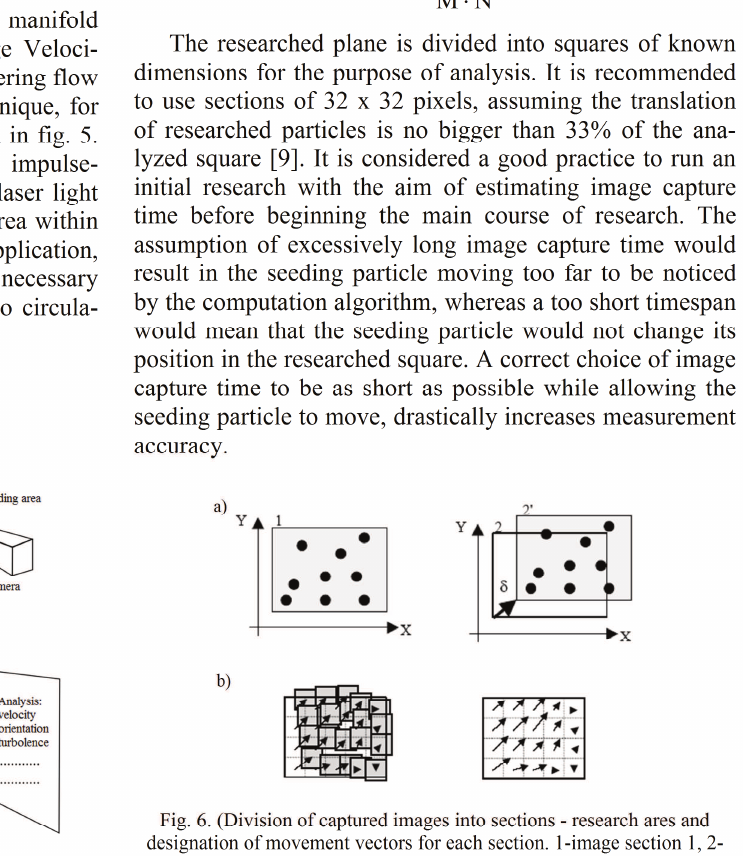
Fig. 5. Measurement scheme of DPIV method [11]